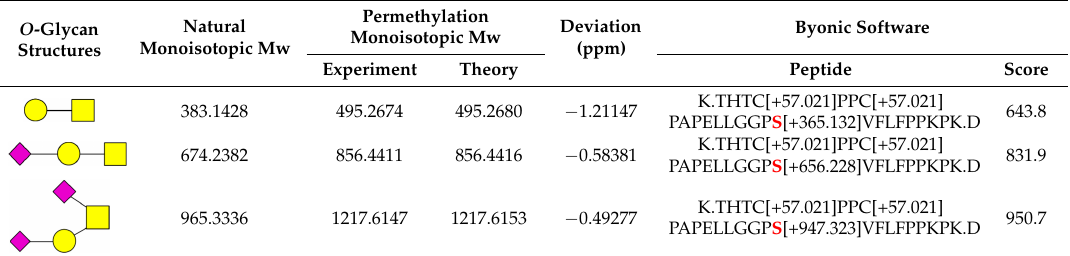
Table 3. The list of identified O-glycans.